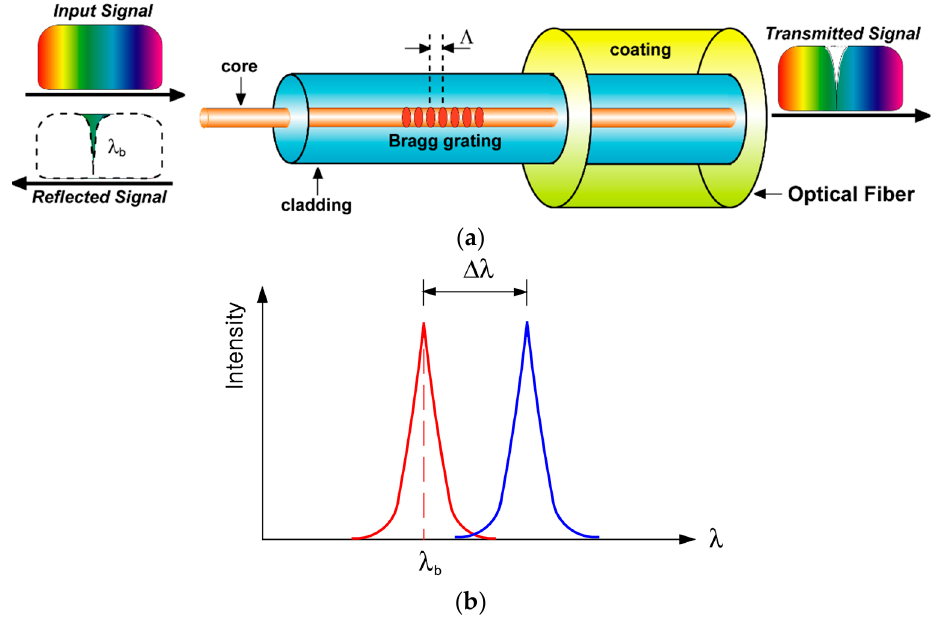
Figure 2. Schematic diagram of an FBG sensor: ( a ) principle of the FBG sensor; ( b ) wavelength shift due to deformation by a temperature change or external force [22].